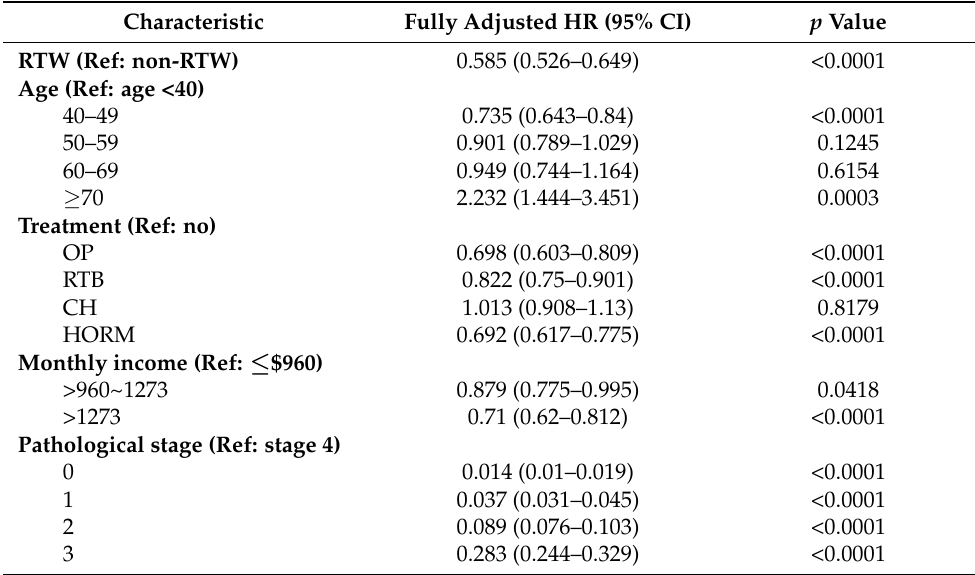
Table 4. Multivariate analysis of relationship between independent variables and all-cause mortality of breast cancer